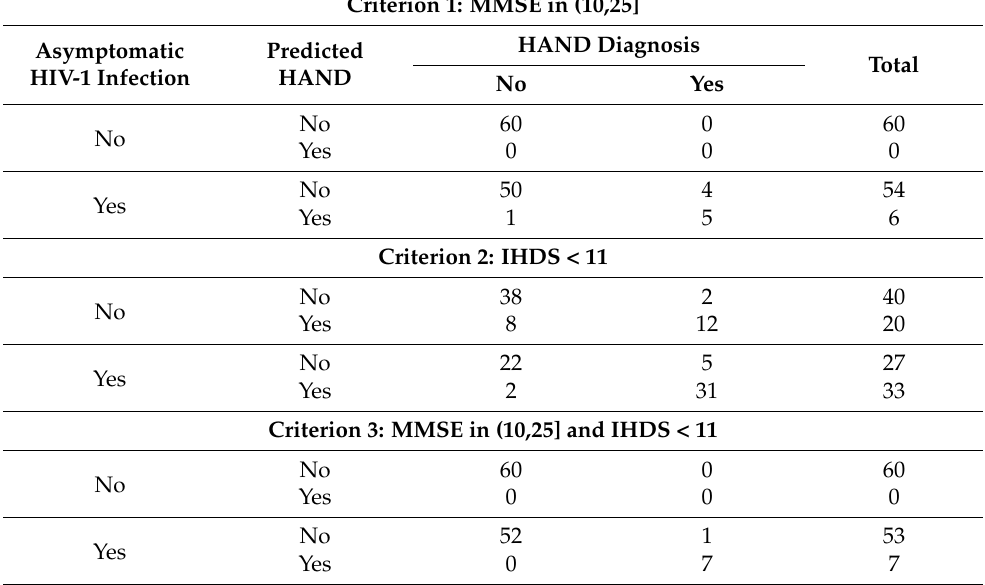
Table 5. Number of individuals with HAND and ARPA-based predicted HAND diagnosis by HIV- 1 infection status. HAND diagnosis was defined according to three different criteria. For each criterion, age, sex, years of education, and tasks comprising our short screening protocol were used as predictors in the ARPA-based